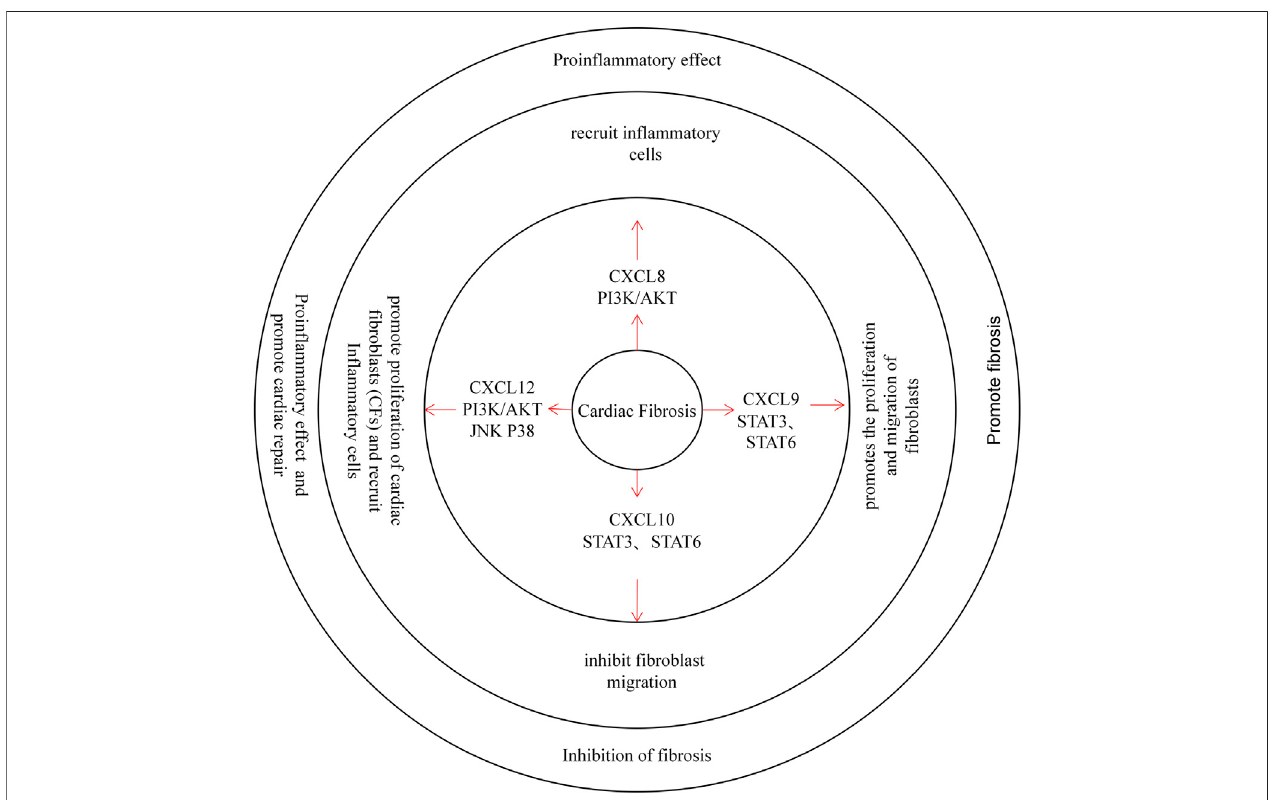
FIGURE 3 | CXC chemokines in Cardiac Fibrosis. CXCL8 recruits in fl ammatory cells through the PI3K / AKT pathway and plays a pro-in fl ammatory role. CXCL9 promotes the proliferation and migration of fi broblasts through the STAT3 and STAT6 pathway, promoting cardiac fi brosis. Instead, the CXCL10 inhibit fi broblast migration and protects the heart from Cardiac Fibrosis. CXCL12 can promote the proliferation of cardiac fi broblasts (CFs), and recruit in fl ammatory cells, while exerting pro-in fl ammatory and repair effects.